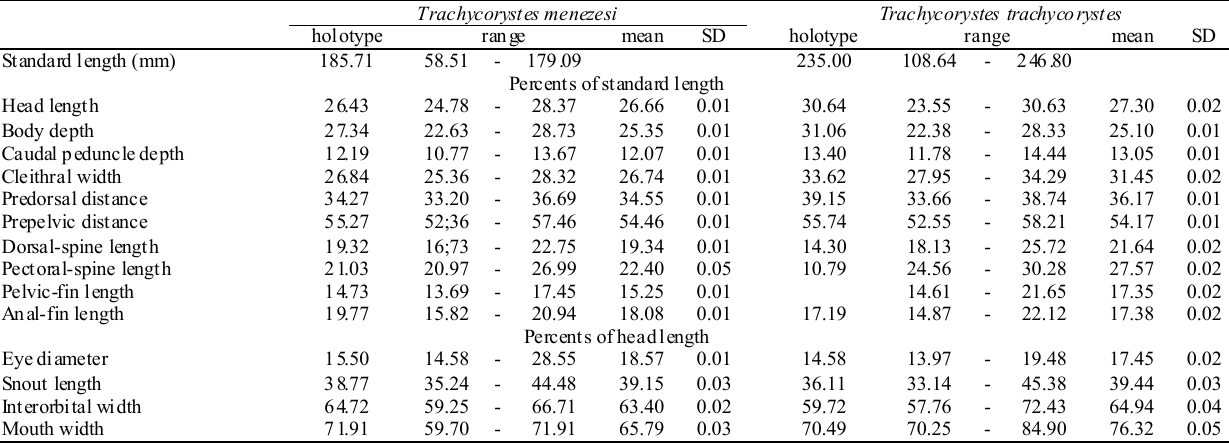
Table 1. Morphometrics of Trachycorystes menezesi (n = 23, ranges include holotype MZUSP 104671) and T . trachycorystes (n = 10, ranges exclude stuffed holotype MNHN